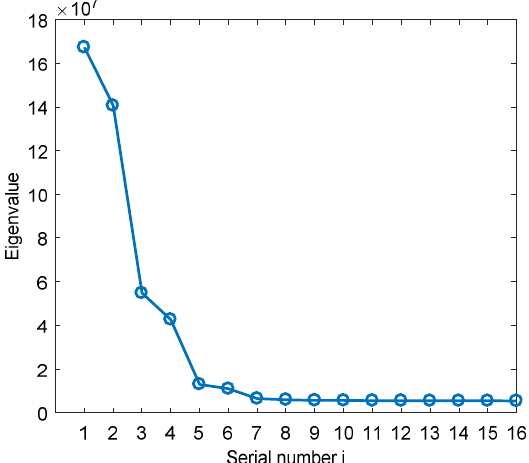
Figure 6. The distribution of the eigenvalues.